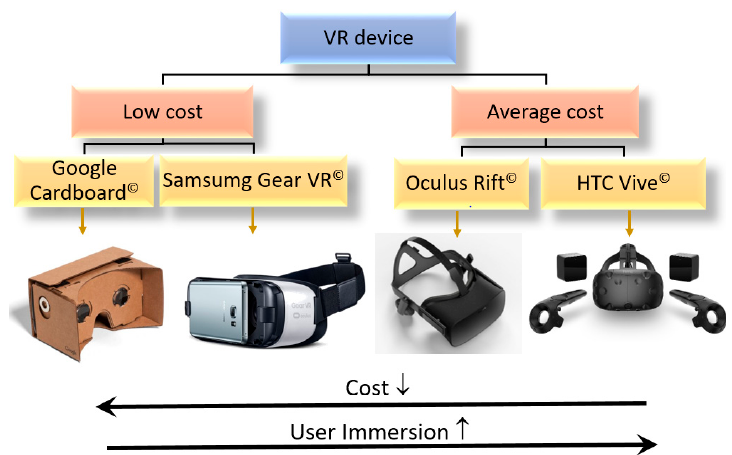
Figure 4. Commercial VR devices: (i) low cost: Google Cardboard© (vr.google.com) and Samsung Gear VR© (www.samsung.com/global/galaxy/gear-vr); (ii) average cost: Oculus Rift©